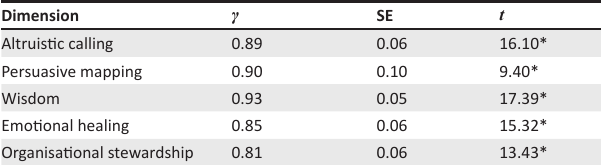
TABLE 6: Unstandardised gamma